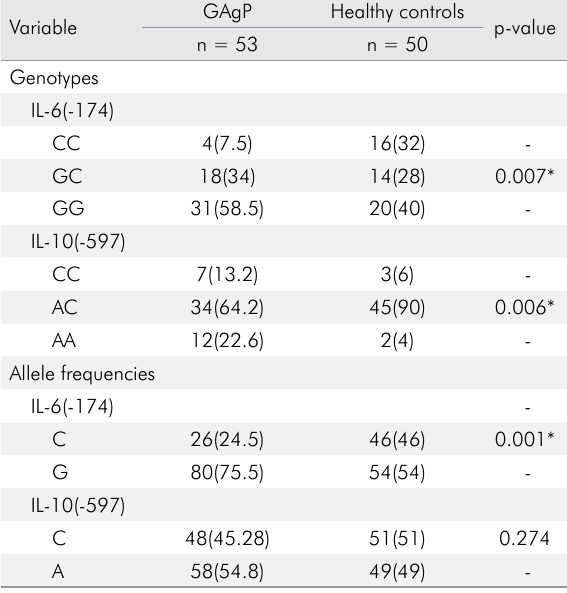
Table 5. Gingival crevicular fluid(GCF) and serum IL-6 and IL-10 levelsat baseline and 6-week (pg/30s,